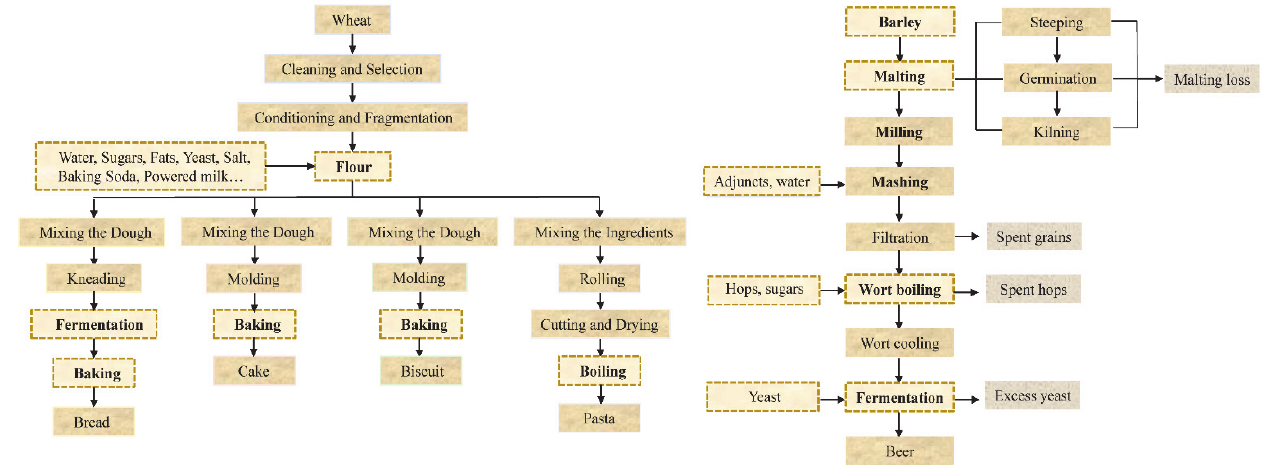
Figure 2. Steps of wheat and beer processing. Steps affecting zearalenone content during food processing were marked with dotted line.